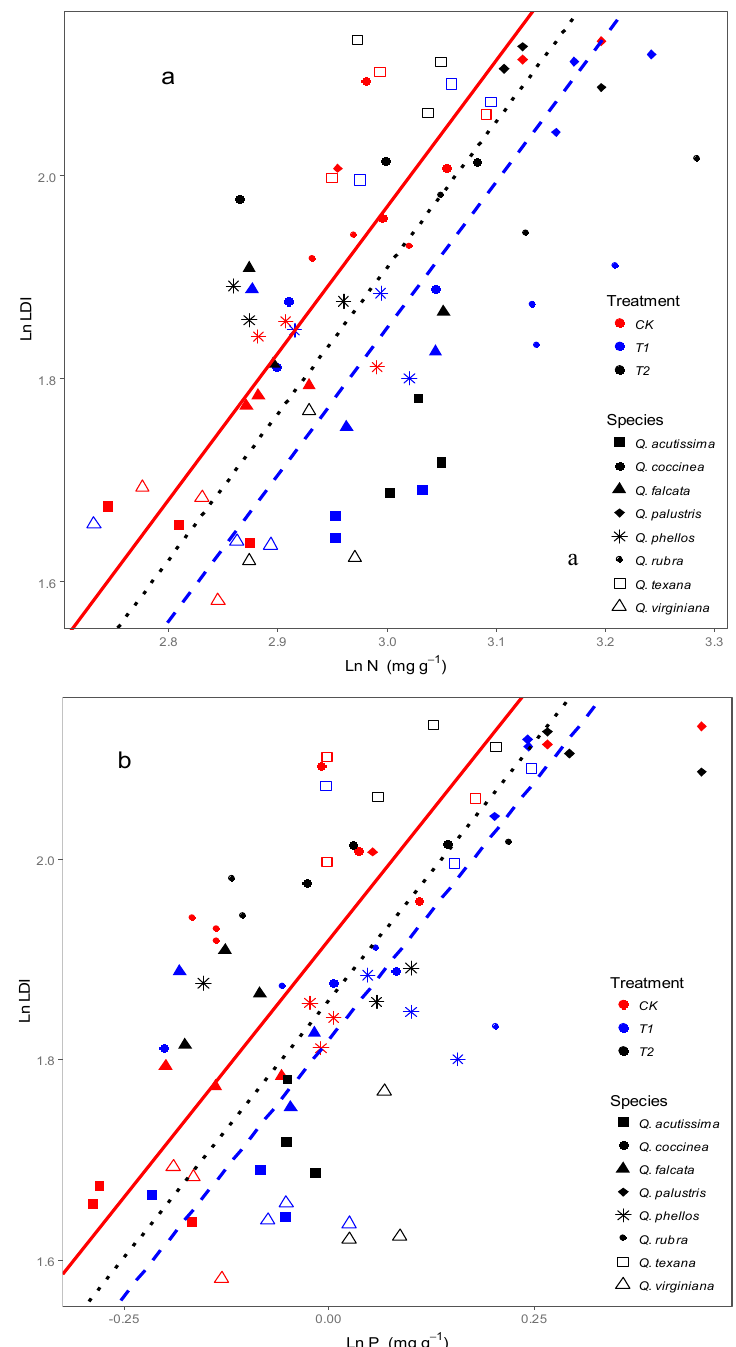
Figure 4. Relationships between leaf N, P concentrations and LDI (Leaf dissection index) for Quercus species under wind load. Ln N, Ln P and Ln LDI: leaf N ,P concentrations and LDI were transformed using the natural logarithm prior to analysis. CK : control, T1 : about 4 m s − 1 wind speed, T2 : about 6 m s − 1 wind speed. ( a ) Leaf N concentration and LDI. CK : y = 1.19 x − 1.58, R 2 = 0.41, p < 0.01; T1 : y = 0.83 x − 0.67, R 2 = 0.45, p < 0.01; T2 : y = 0.78 x − 0.44, R 2 = 0.23, p = 0.02. SMAs fitted among treatments did not show significant differences in slope ( p = 0.55), but apparent in intercept ( p < 0.01); ( b ) Leaf P concentration and LDI. CK : y = 0.90 x + 1.95, R 2 = 0.436, p < 0.01; T1 : y = 0.73 x + 1.83, R 2 = 0.43, p < 0.01; T2 : y = 0.48 x + 1.89, R 2 = 0.22, p = 0.02. SMAs fitted among treatments did not show significant differences in slope ( p = 0.83), but apparent in intercept ( p =